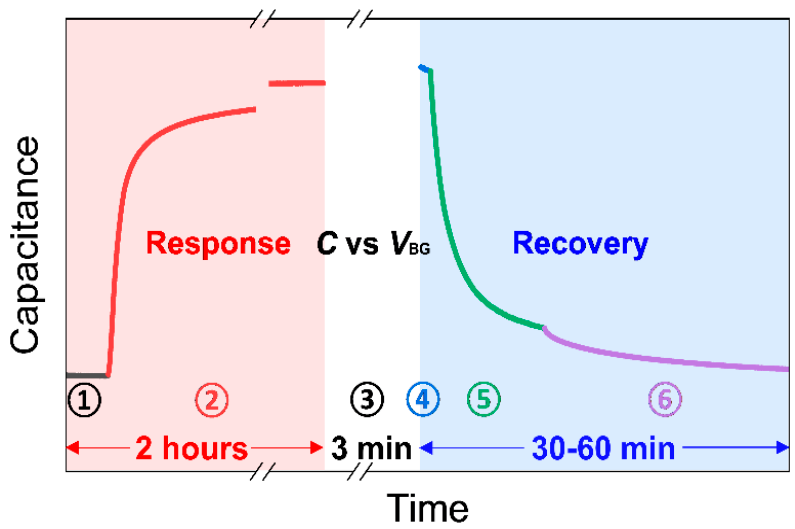
Figure 3. An example of a single measurement process consisting of ‘Response’ period, ‘ C total vs. V BG ’ period, and ‘Recovery’ period. Detailed explanations for each stage number from ➀ to ➅ are given in Section 2.3.